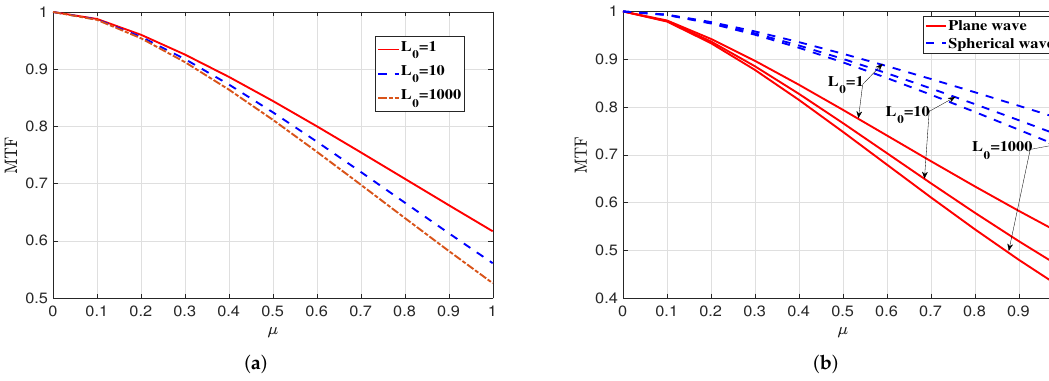
Figure 6. Long-exposure MTF as a function of normalized spatial frequency of outer scale of the turbulence for ( a ) Gaussian beam wave ( b ) plane and spherical